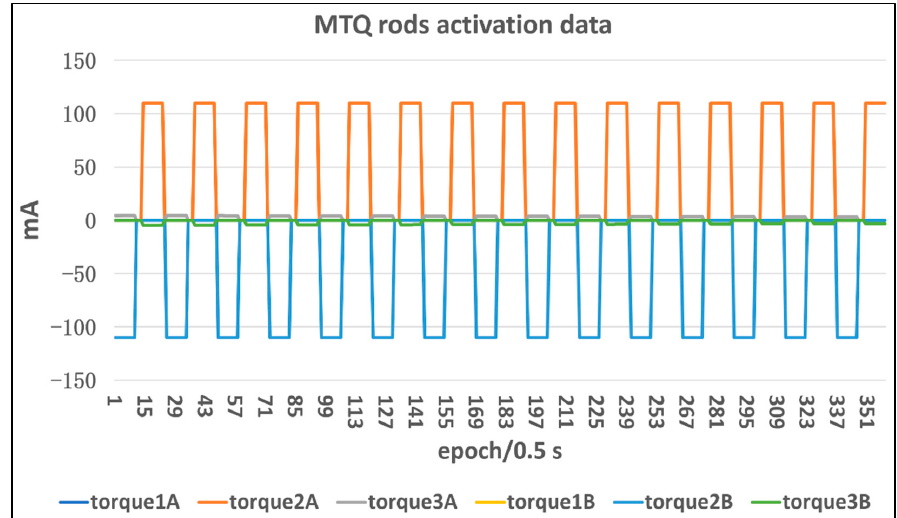
Figure 2. MTQ rod activation to achieve the pitch maneuver. The three axes of the MTQ rods were installed in parallel with the three axes of the satellite. The three axes of the magnetic torque rods were all composed of a cylindrical core and two coils. By applying an electric current in a given axial direction, a magnetic Earth’s magnetic field B , the desired magnetic torque can be generated T m B = × . The uniaxial magnetic dipole moment of the GRACE satellites ranged from − 30 to +30 2 Am , and its axial alignment with the satellite system was 0.06 degrees. The GRACE-FO satel- lites produced uniaxial magnetic dipole moments ranging from − 27.5 to +27.5 2 Am .